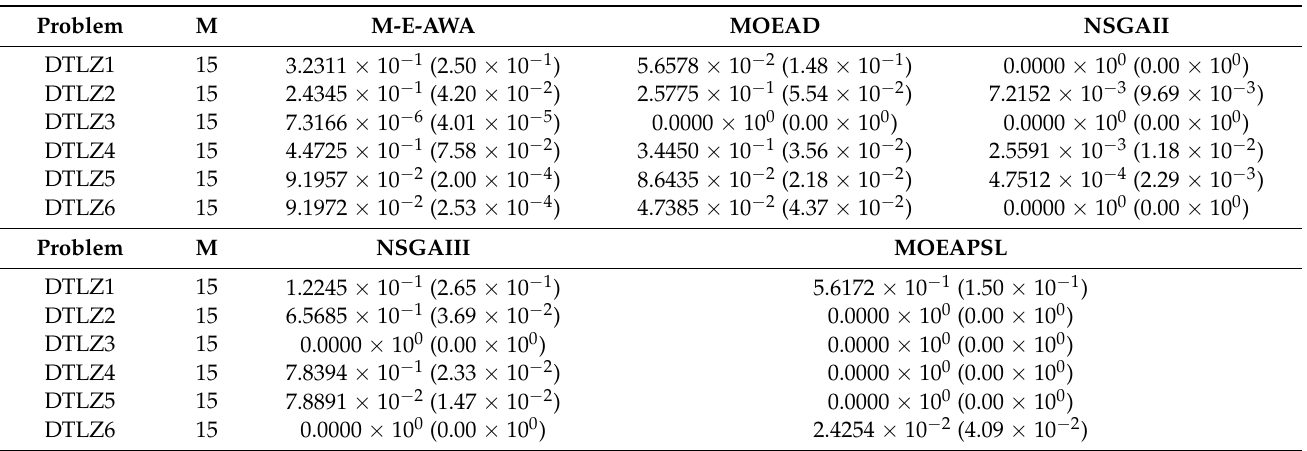
Table 8. Comparison of HV values between M-E-AWA and contrast algorithms on DTLZ1– DTLZ6(The target number is